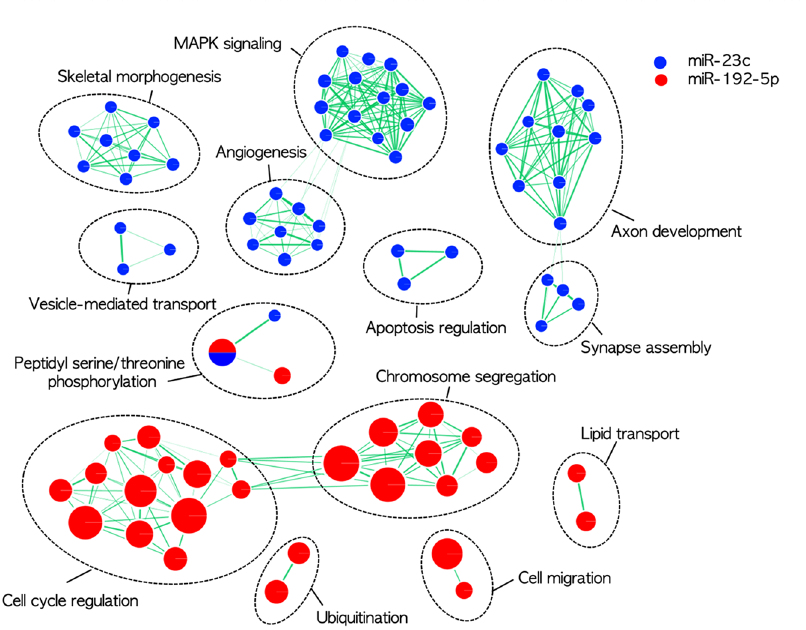
Figure 3. Enrichment map illustrating significantly over-represented pathways (Gene Ontology biological process) for the genes targeted by miR-23c (blue) and miR-192-5p (red), respectively. Enrichment results were mapped as a network of gene sets (nodes) which are grouped together as a subnetwork by their shared genes. Node size is proportional to the total number of genes within each gene set. Edge represents the gene overlap between gene sets, and its thickness is proportional to size of the